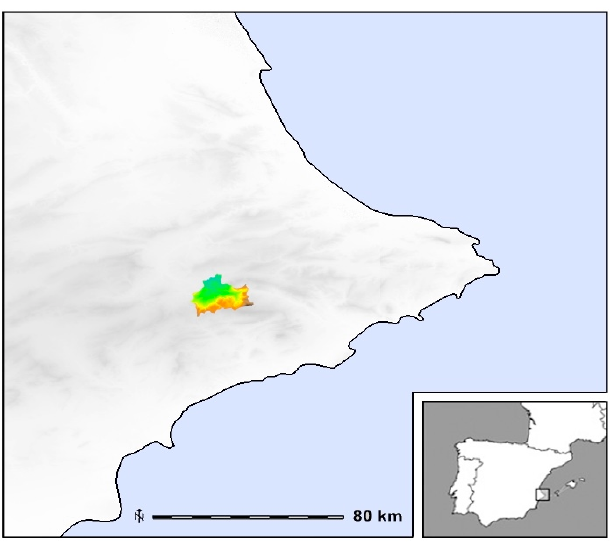
Figure 2. Map of Southeast Spain, showing the location of the Rio Penaguila valley project area.